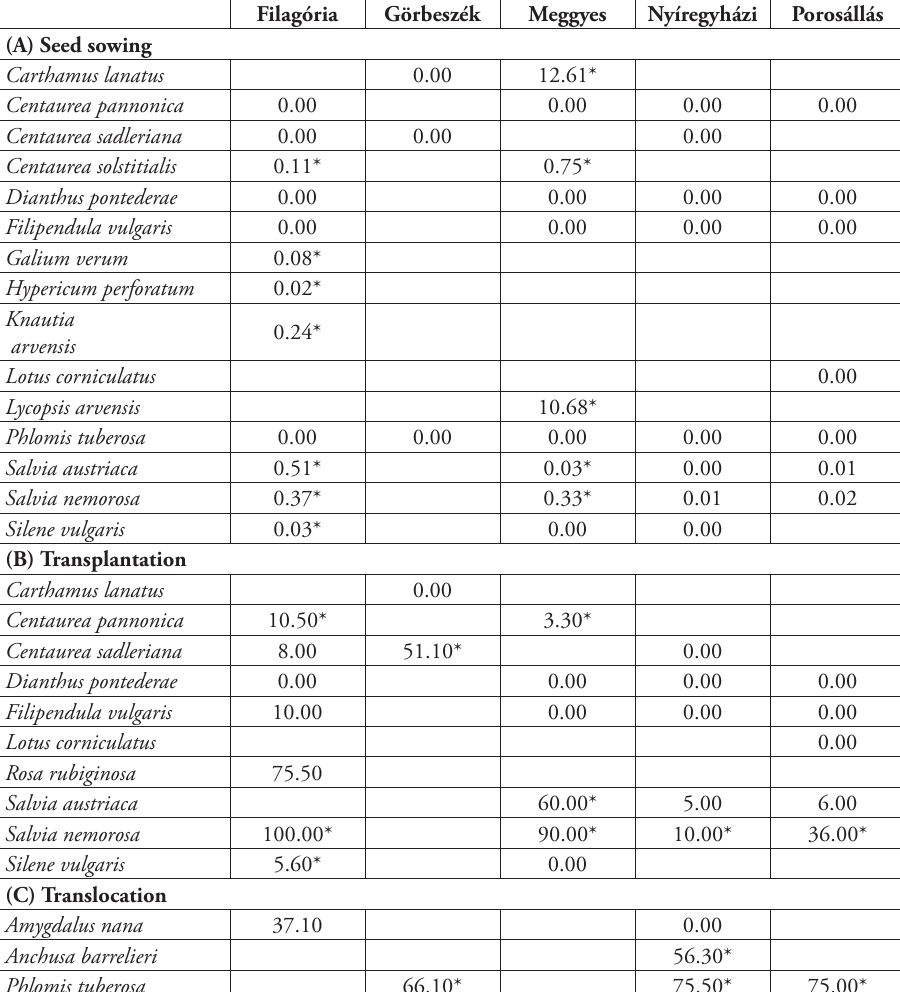
Table 3. Establishment rates in September 2015 (%) of (A) sown species, (B) greenhouse-grown trans- plants and (C) individuals translocated from threatened natural populations. Species which had flowering individuals are marked with an